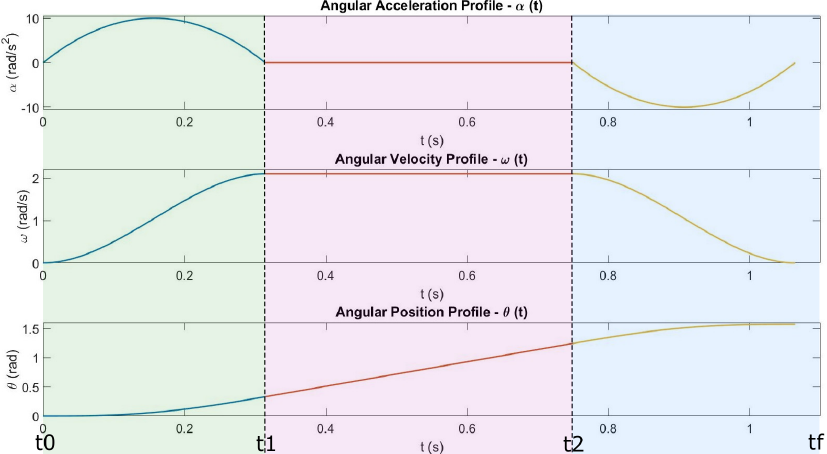
Figure 2. Angular Acceleration, Velocity and Position